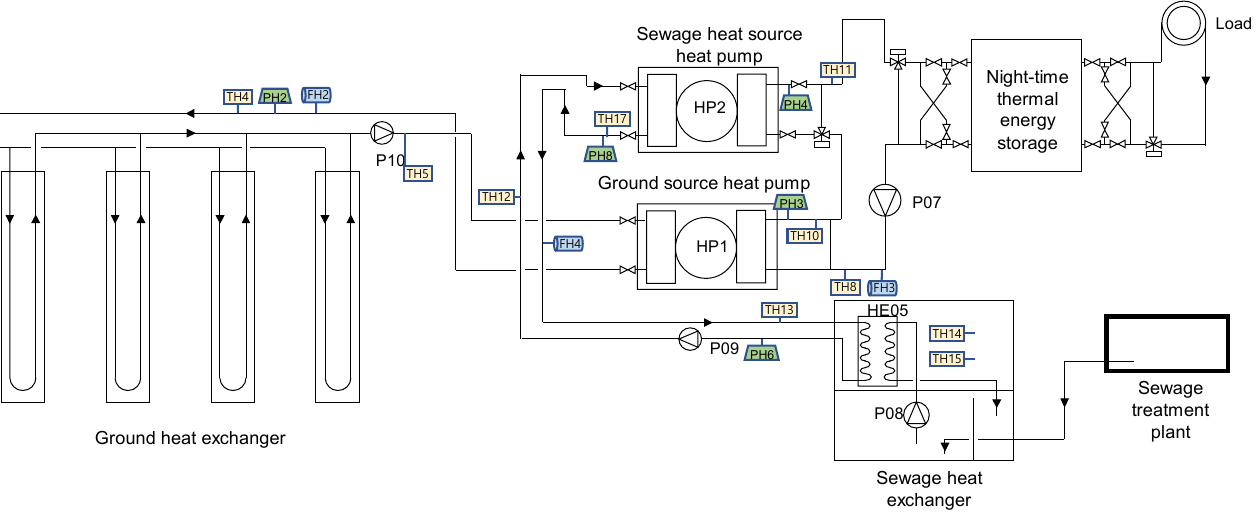
Figure 2. System configuration of the ground source and sewage water source heat pump.